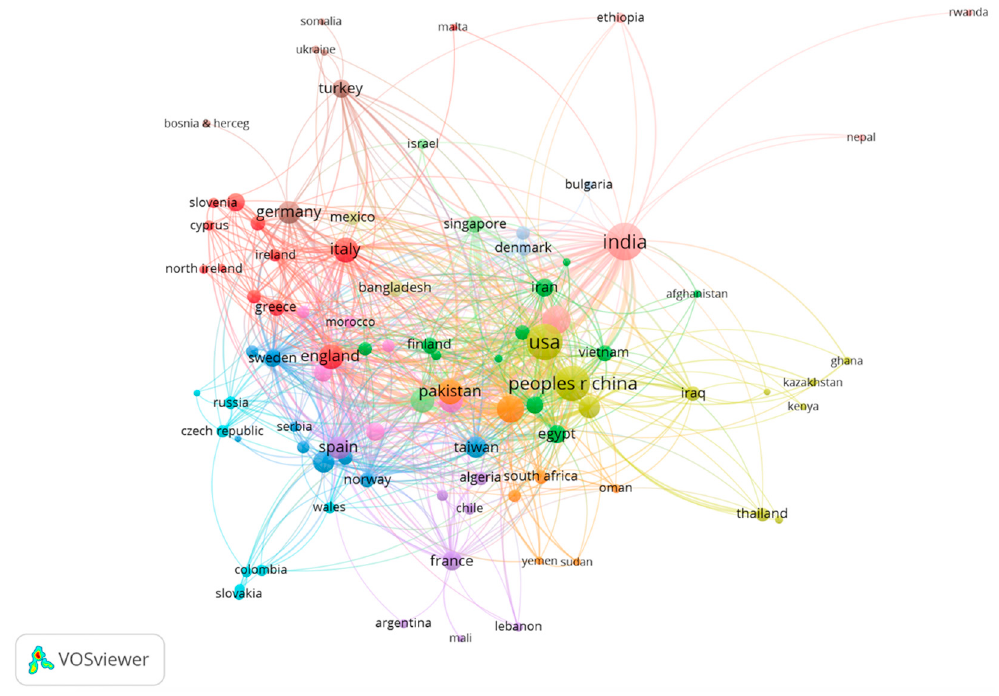
Figure 6. Co-authorship map of countries.